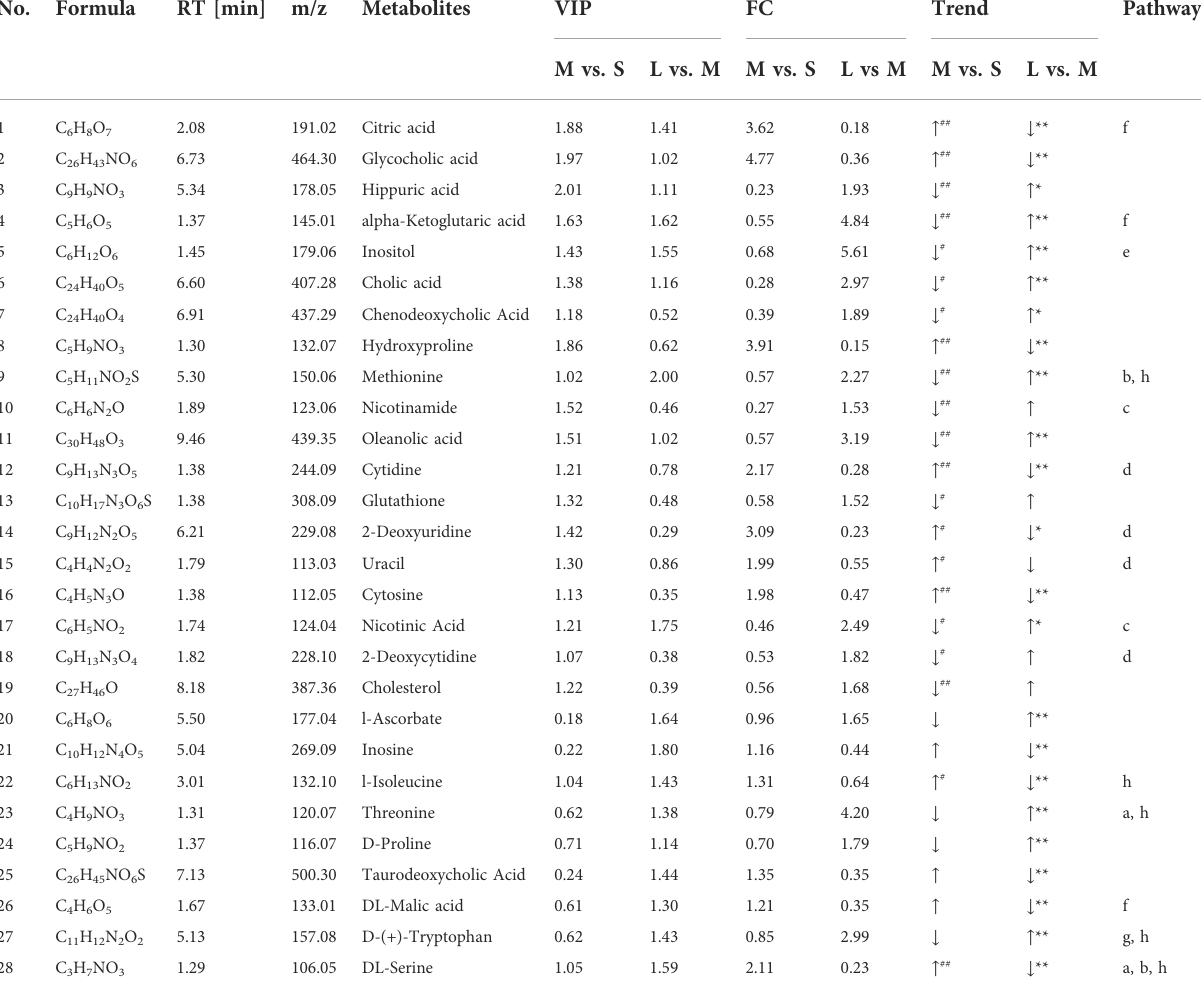
TABLE 4 Differential metabolites in lung in sepsis-associated lung injury model rats after the treatment of LG. No. Formula RT [min] m/z